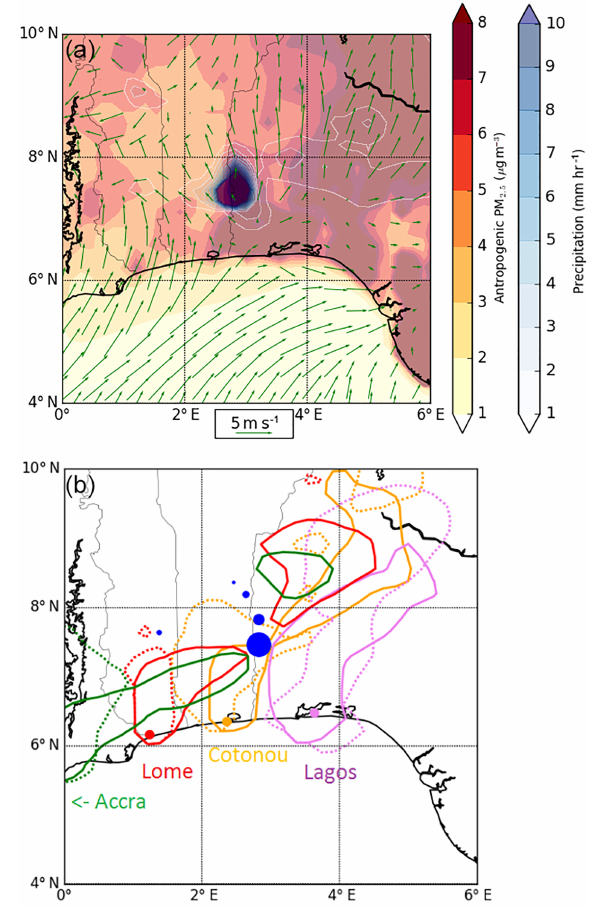
Figure 13. (a) Map of Cotonou area for the 11 June 2006 at 19:00UTC with wind vectors at 10m (green arrows), precipita- tion (blue shading), and anthropogenic PM 2 . 5 concentration (red shading); (b) isocontours of tracer concentration on 11 June at 19:00UTC (solid line) and on 12 June at 01:00UTC (dashed line), released in Accra (Ghana) in green, Lome (Togo) in red, Cotonou (Benin) in orange, and Lagos (Nigeria) in violet. Blue dots show precipitation location each hour between 11 June at 19:00UTC and 12 June at 01:00UTC (the size of blue dots depends on precipitation